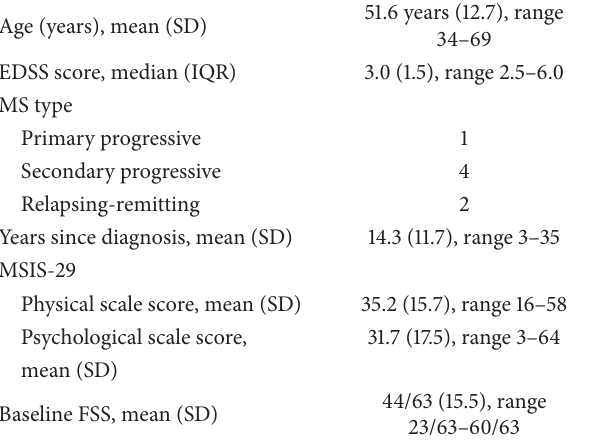
Table 1: Participant characteristics.